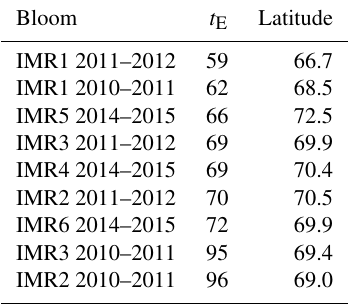
Table 3. Time of “emergence from noise” ( t E ) in year-day, and lat- itude ( ◦ N) at t E . The events have been sorted in increasing day of the year from top to bottom.